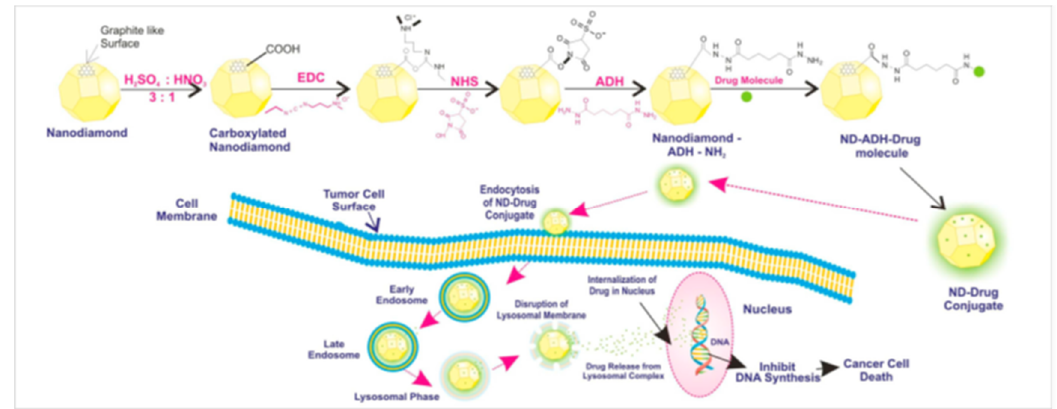
Figure 7. Graphical representation of conjugation pattern of ND–drug conjugates and the proposed hypothesis of the tumor targeting strategy of the ND–drug conjugate. Reprinted from Diamond and Related Materials, 94, Garg, S.; Garg, A.; Sahu, N.K.; Yadav, A.K. Synthesis and characterization of nanodiamond-anticancer drug conjugates for tumor targeting, 172–185 [48], Copyright (2019), with permission from Elsevier.